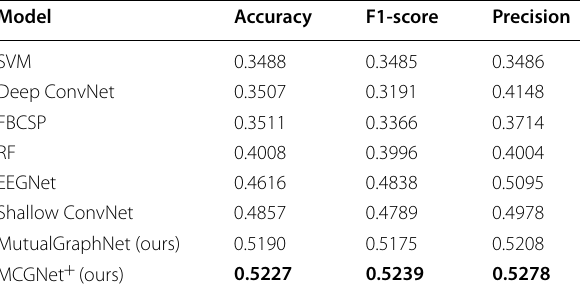
Table 2 The performance comparison of the state-of-the-art approaches on the SMR dataset